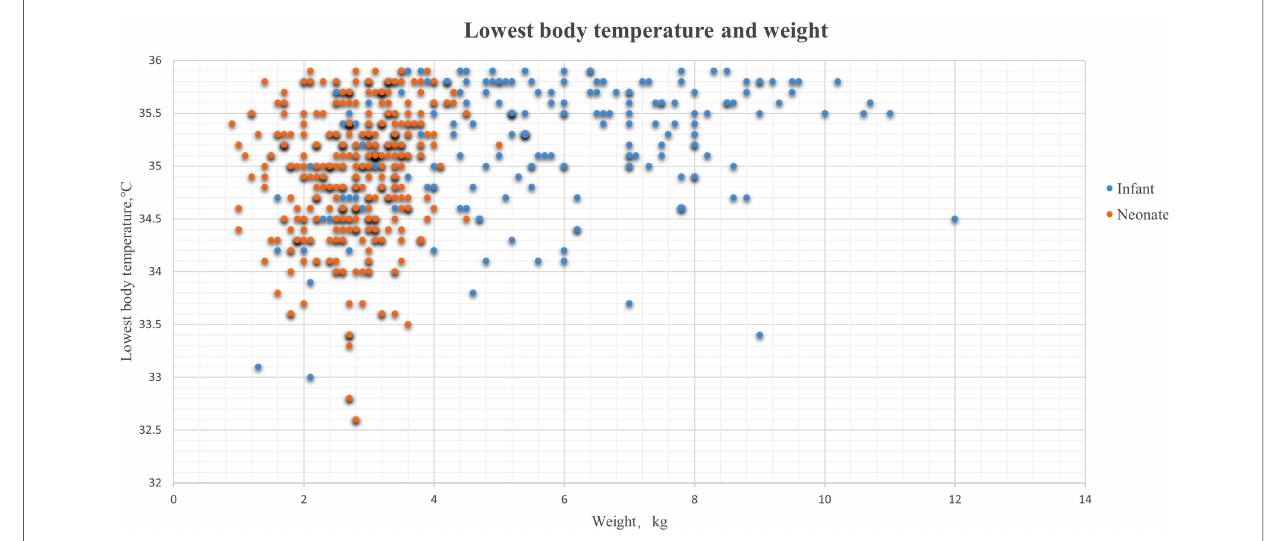
FIGURE 2 Lowest body temperature and weight in hypothermia patients. The blue dots were the lowest body temperatures during the surgeries in infant patients, and the orange dots represent the lowest body temperature in neonates.